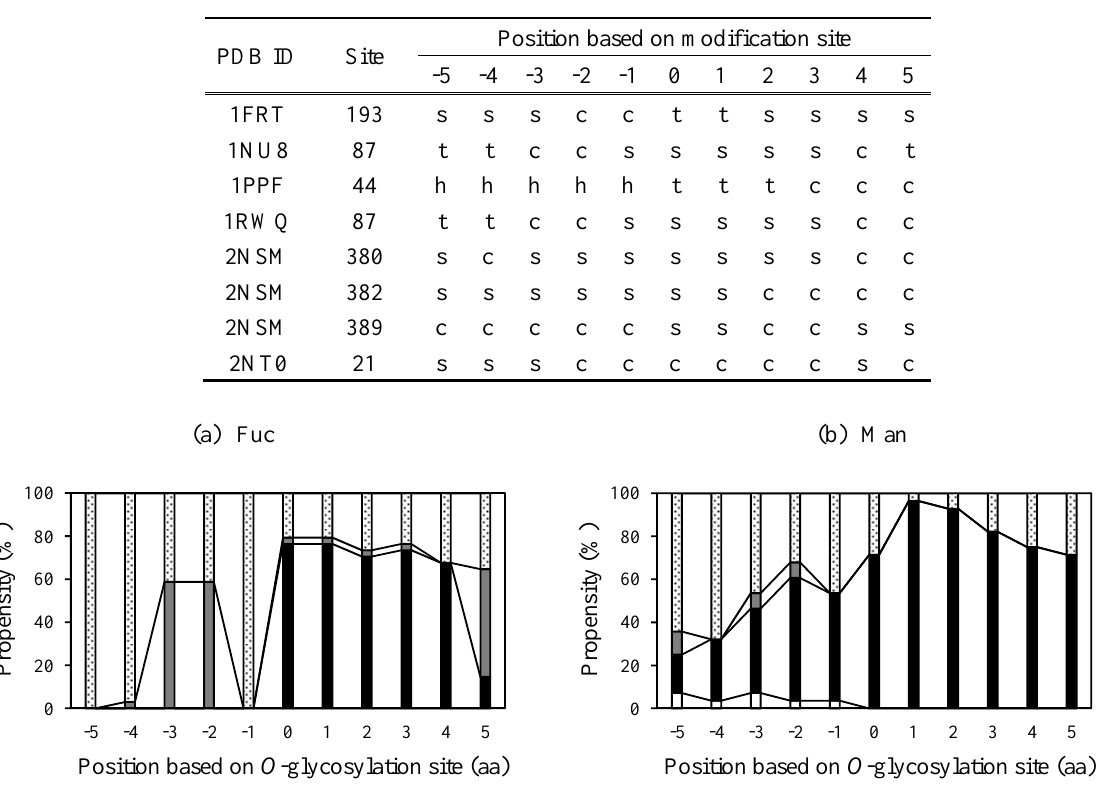
Secondary structure propensities around GlcNAc modification sites h: Helix, s: Strand, t: Turn and c: Coil